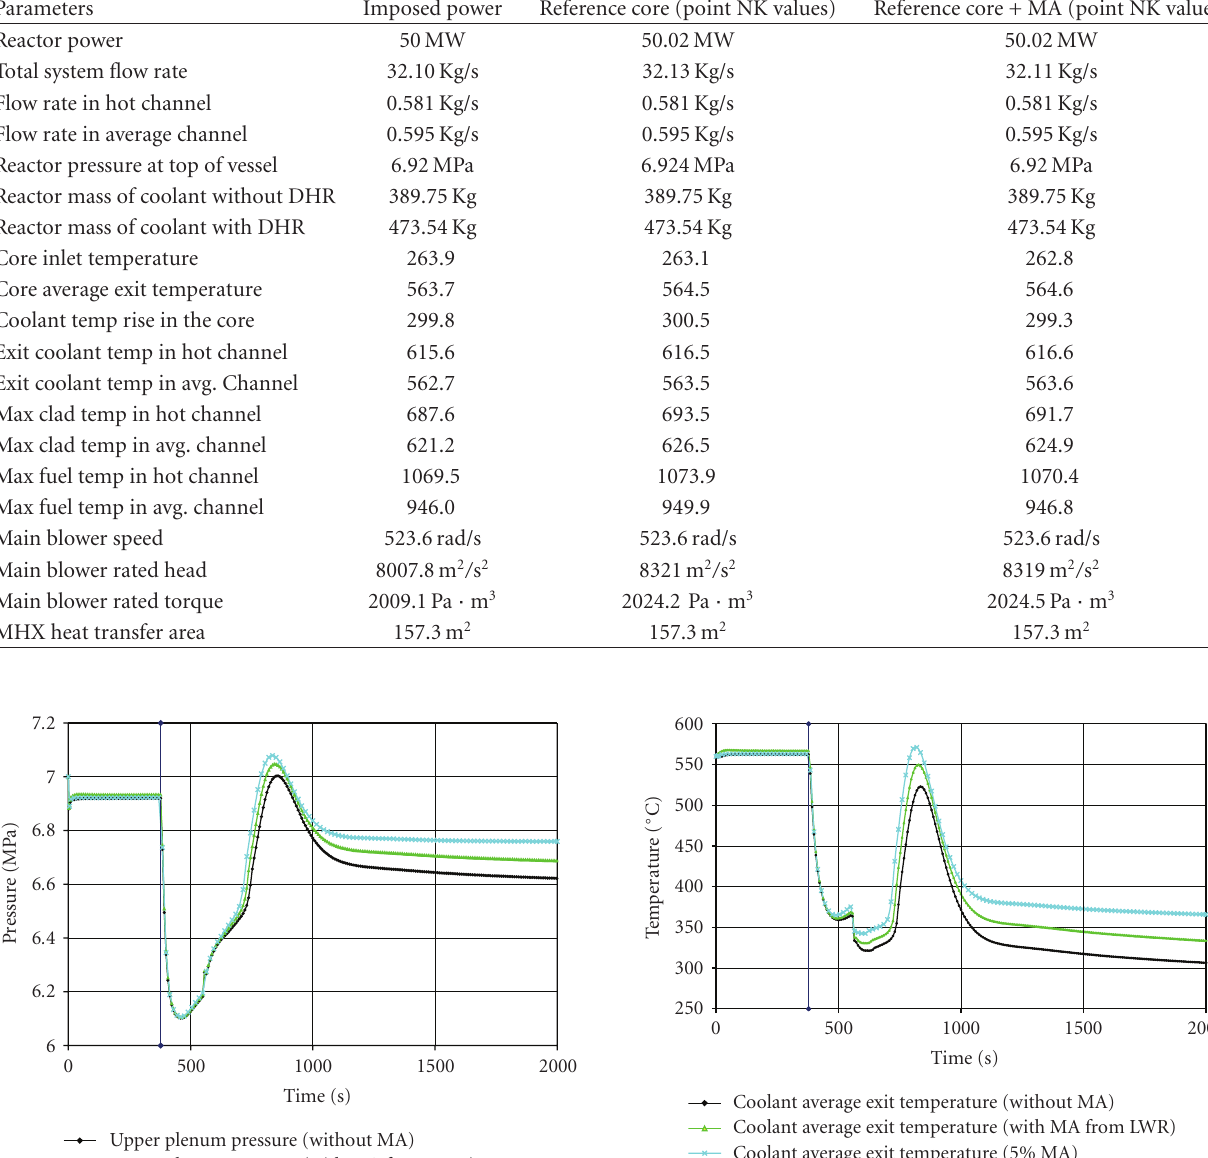
Table 2: Point Neutron Kinetics (NK) core parameters (with and without MA)